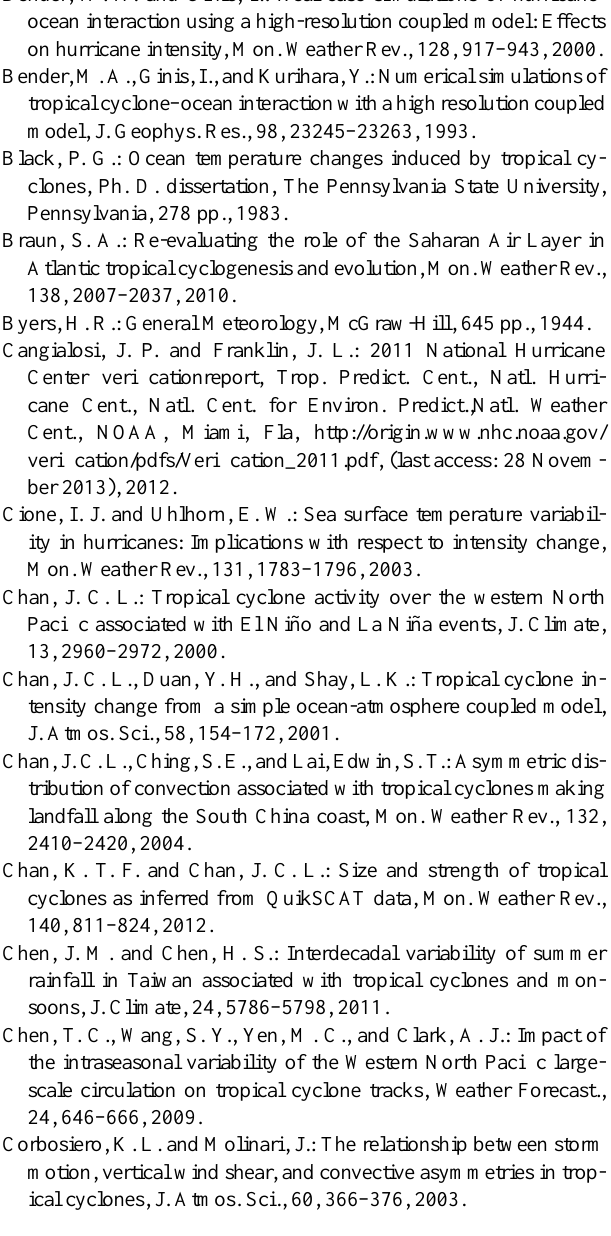
Values in the parentheses mean the SSTs and POTs for the two groups with geographic restrictions (see text for